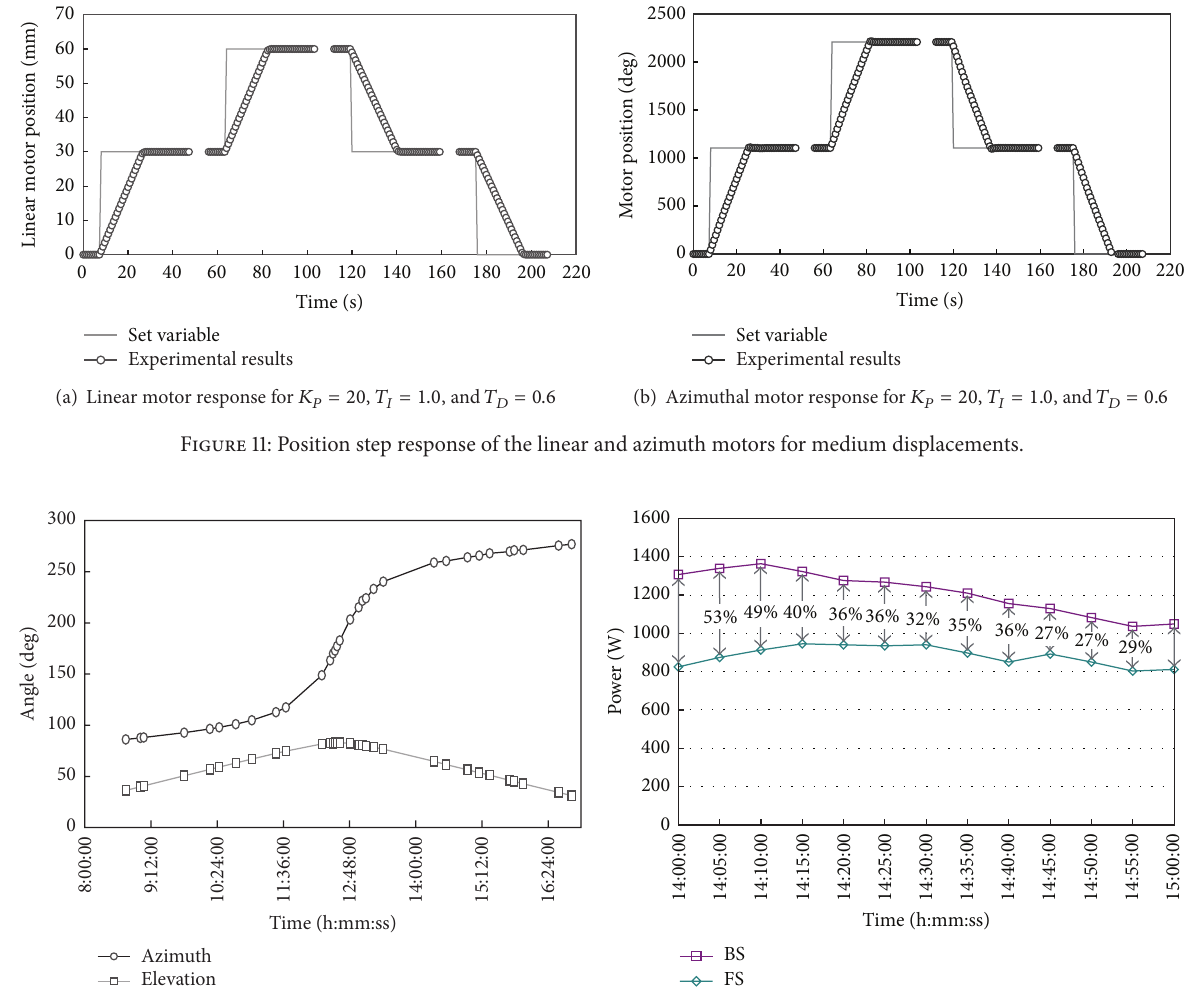
(b) Comparative analysis of efficiency between the biaxial (BS) and fixed system (FS) Figure 12: Experimental results measured on November 27,